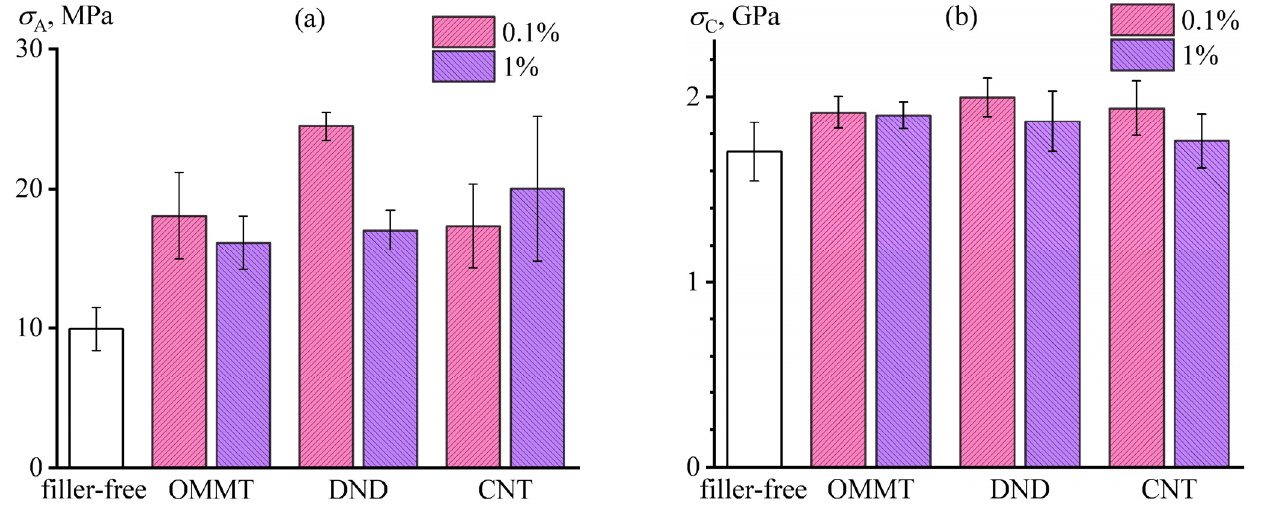
Figure 12. Effect of nanoparticles on the adhesive strength of epoxy binder and carbon fiber bonding ( a ) and the tensile strength of single-bundle carbon plastic ( b ). Legends show the mass fraction of nanoparticles in the epoxy matrix.